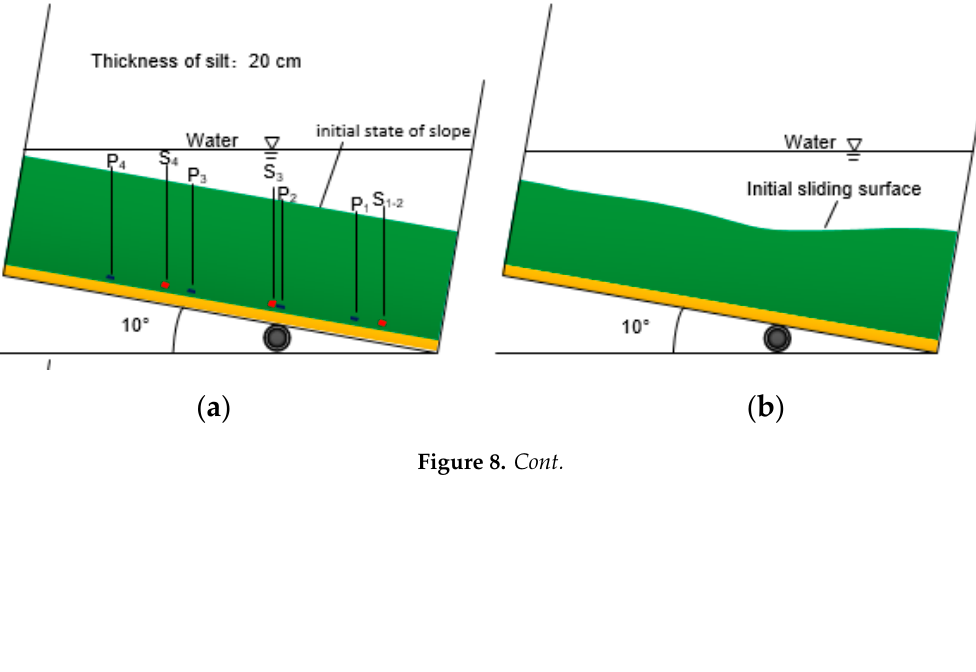
Figure 7. Profile and plan views of the slope after failure in Model 20-5. ( a ) Before Angle adjustment; ( b ) After the Angle adjustment; ( c ) After the destruction; ( d ) top view of end of experiment.